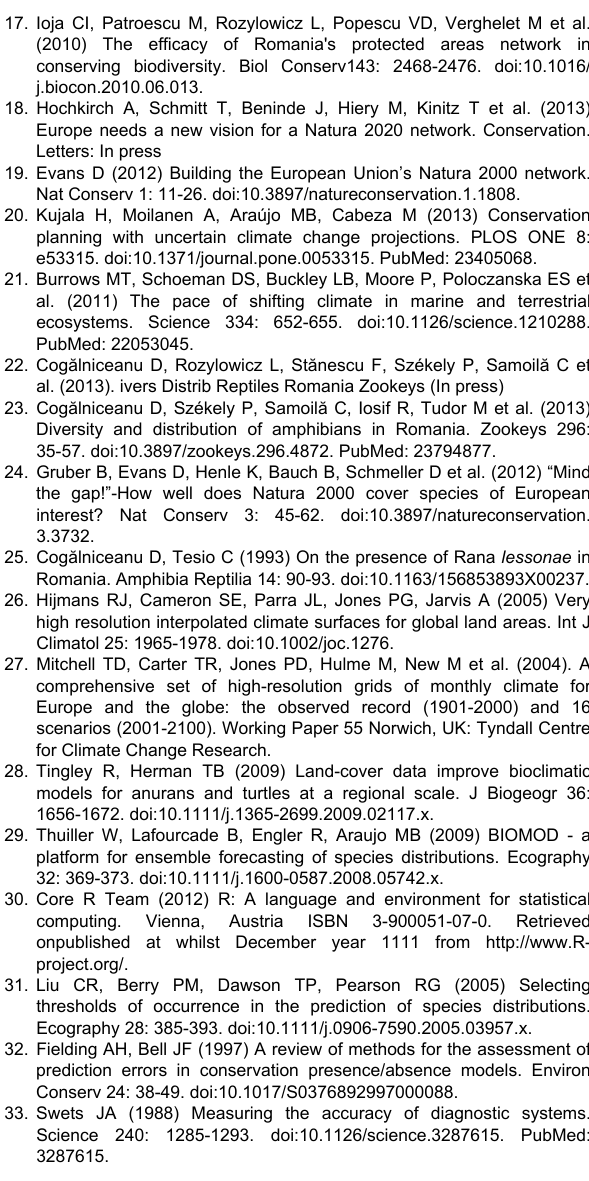
Figure S1. Irreplaceability scores of planning units (10 ×10 km grid cells) for 2020s (a) and (b) and 2050s (c) and (d) under limited-dispersal (LimD) and no-dispersal (NoD) assumptions.